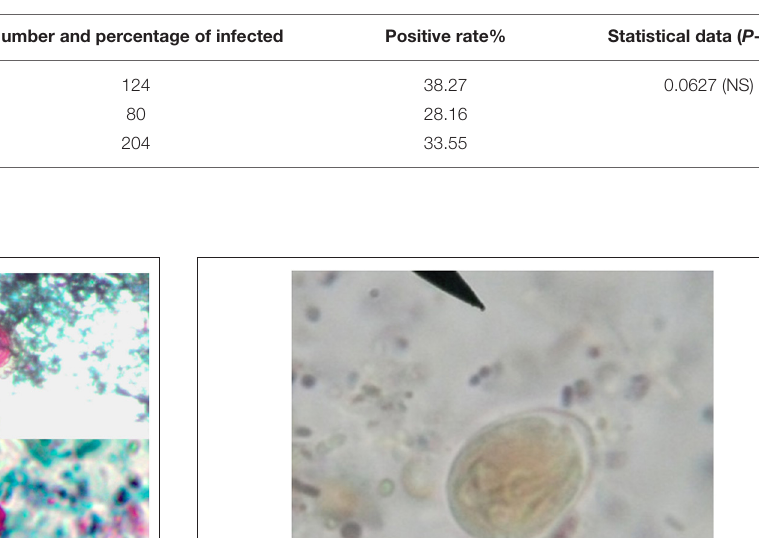
and the sample was placed on a slide and examined under a microscope